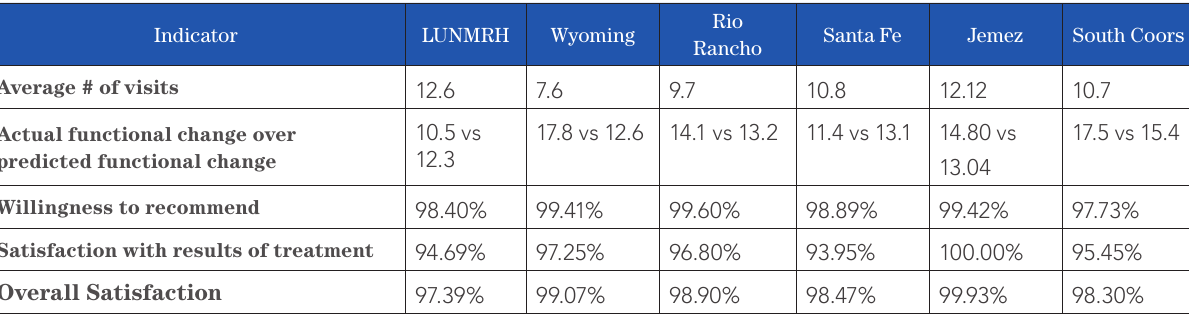
Table 8. Patient outcomes and satisfaction with outpatient therapy by location for